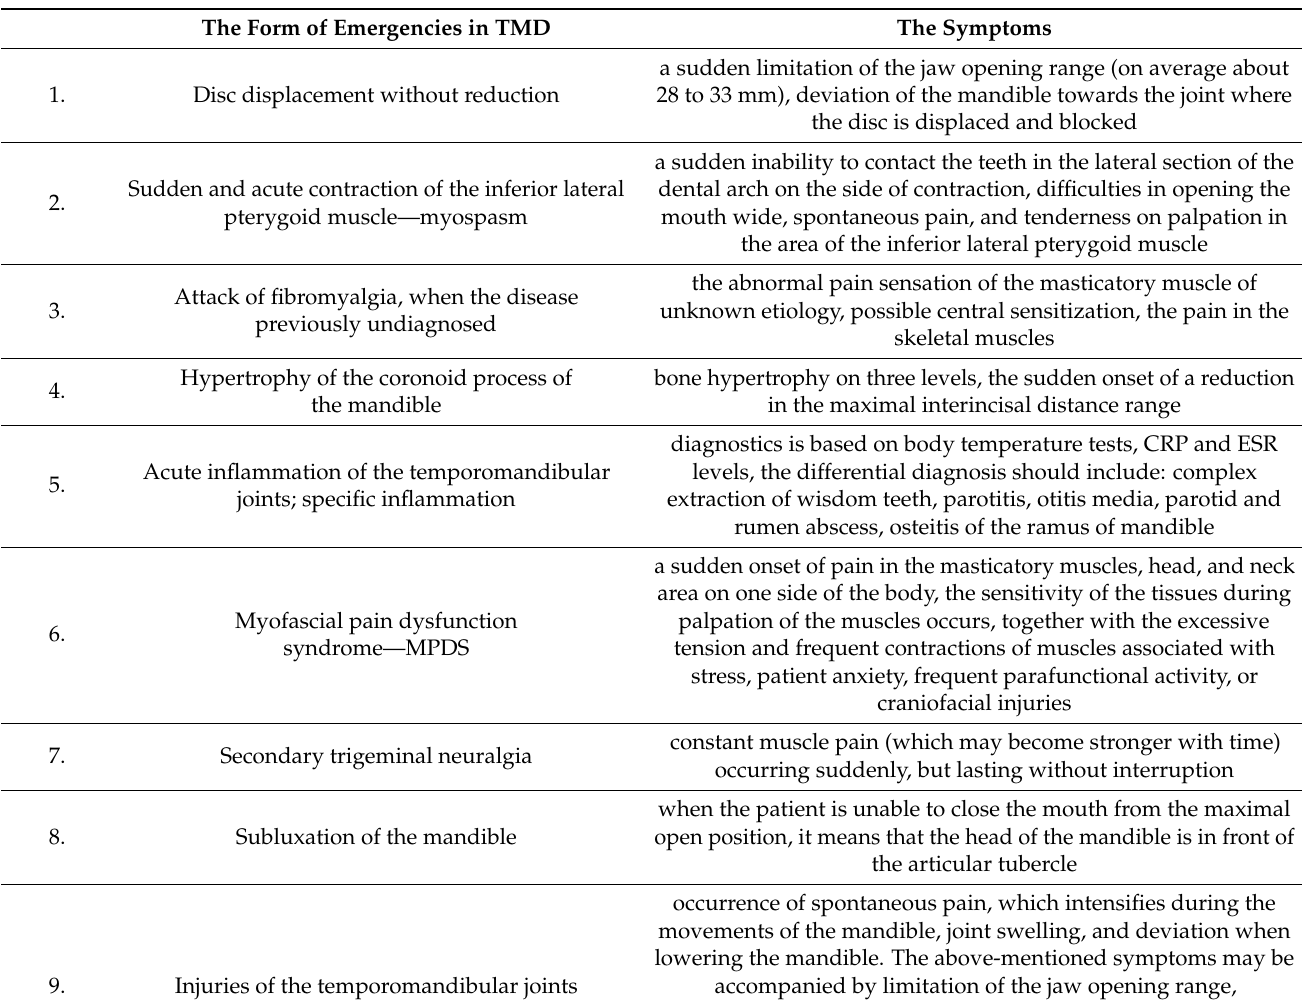
Table 1. Summary of emergencies and their symptoms in the case of TMD